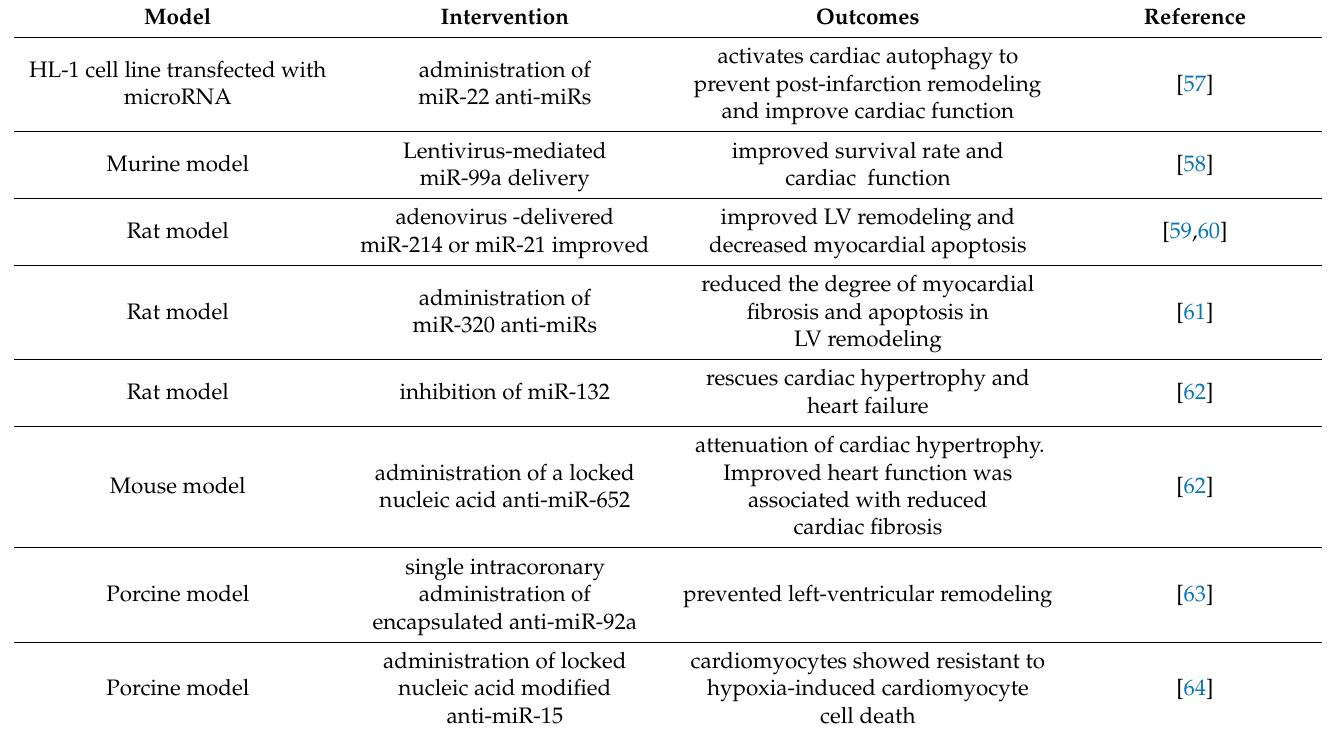
Table 2. Therapeutic delivery of miRNA as biomarker for